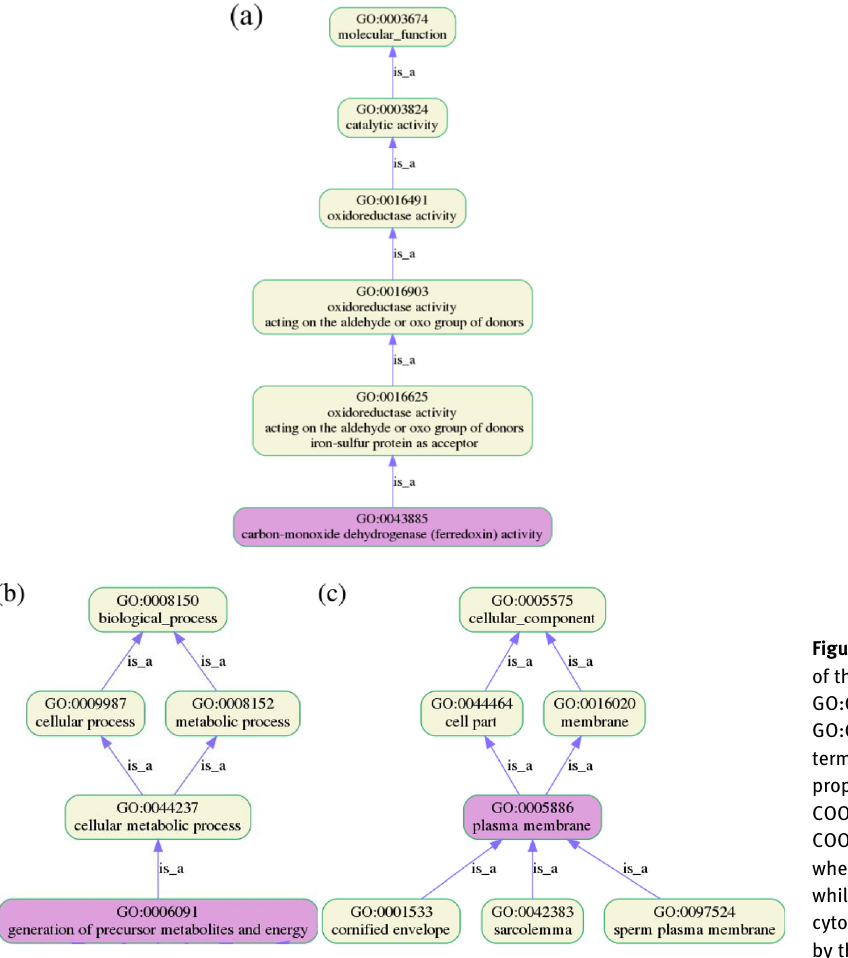
words using PSI-BLAST search against NCBI nr 27 database. The results reported in Table 7 and Table 8 show how the predicted locations have been obtained by the consensus model for the minority multi-label classes in Gram-positive and Gram-negative bacterial proteins datasets respectively. One should be careful in drawing conclusions when comparing SCL methods, since they differ in many aspects such as the learning strategy, features that they learn from since they are extracted from different sources of information, and their coverage of different localizations which depends on the available classes in the learning datasets [124]. In addition each